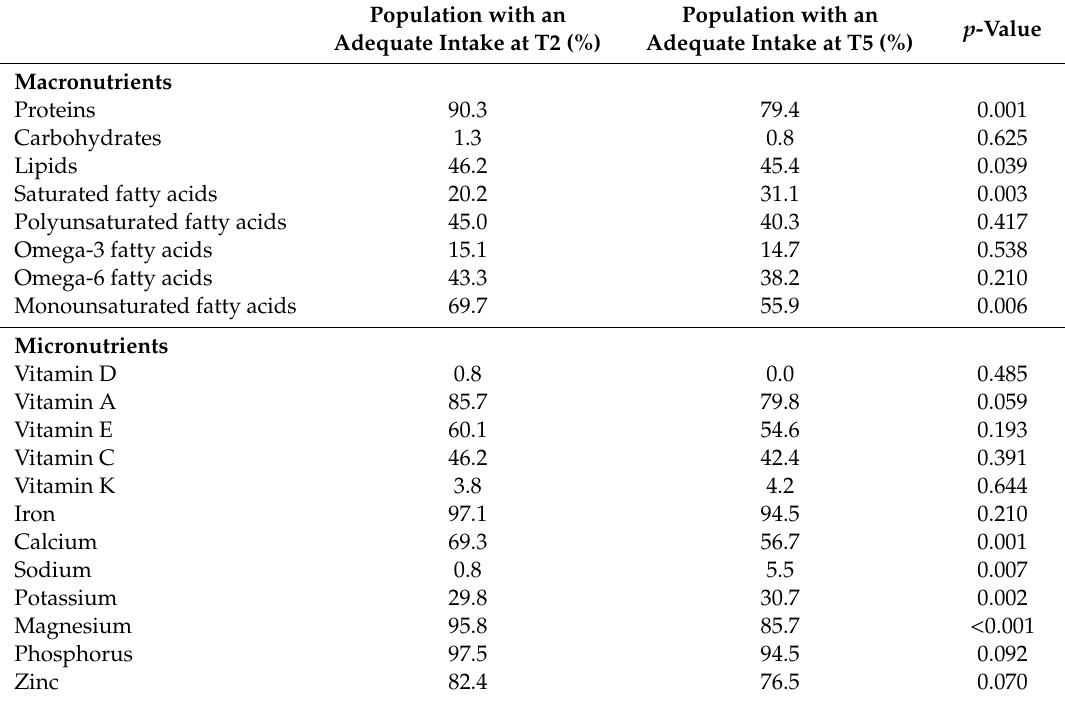
Table A3. Adequation of the consumption of macro- and micronutrients at T2 and T5. Population with an Population with an p Adequate Intake at T2 (%) Adequate Intake at T5 (%)